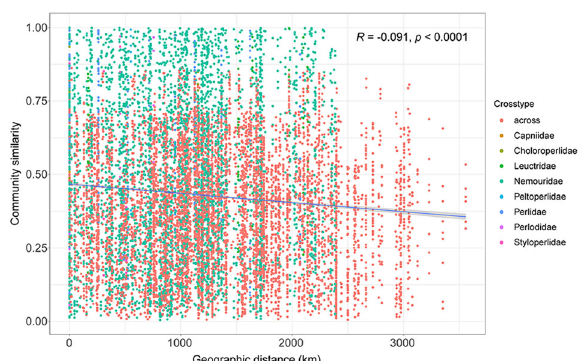
Fig. 3 Geographic patterns in stone fl y fungal communities. Distance-decay curves of fungal communities based on Bray – Curtis similarities in wild populations of stone fl ies. The line represents the ordinary least-squares linear regression.